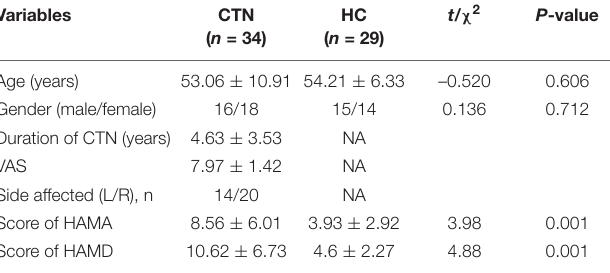
TABLE 1 | Demographic and clinical characteristics.